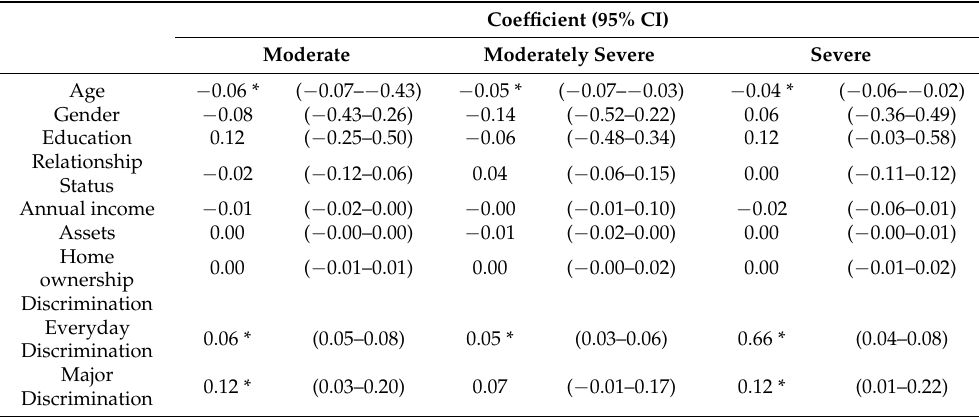
Table 2. Multinomial Regression Predicting Severity of Depressive